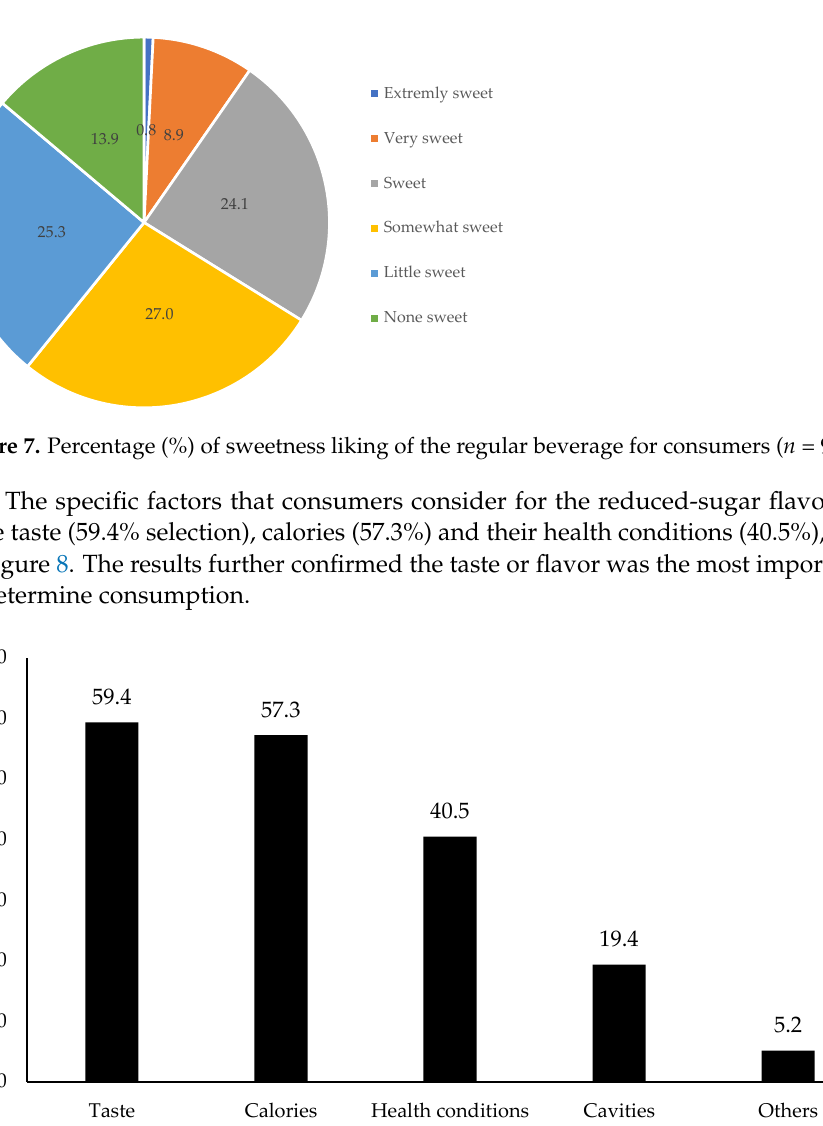
Figure 8. Percentage (%) for the factors that consumers thought were the most important when they chose sugar-reduced products ( n = 901). Others included alternative sweeteners, natural ingredients (artificial sweeteners), and carbohydrates according to the collected data.